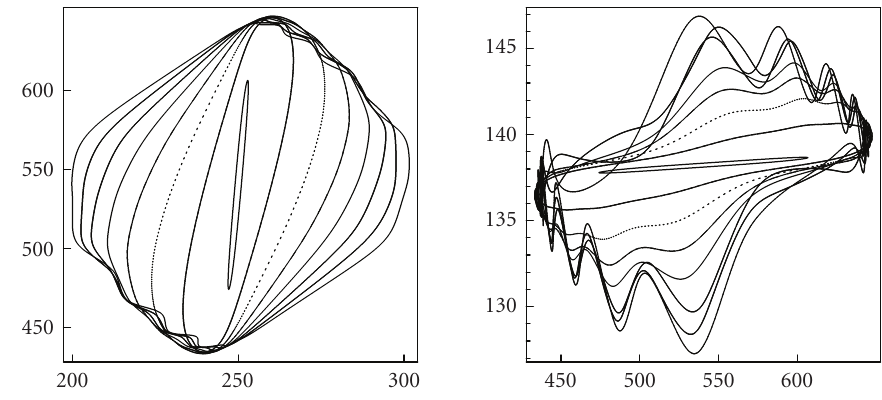
Figure 6.2. Development of cyclical attractors for β = 1 . 8. Projections in the Y - K (left) and K - M (right) planes.